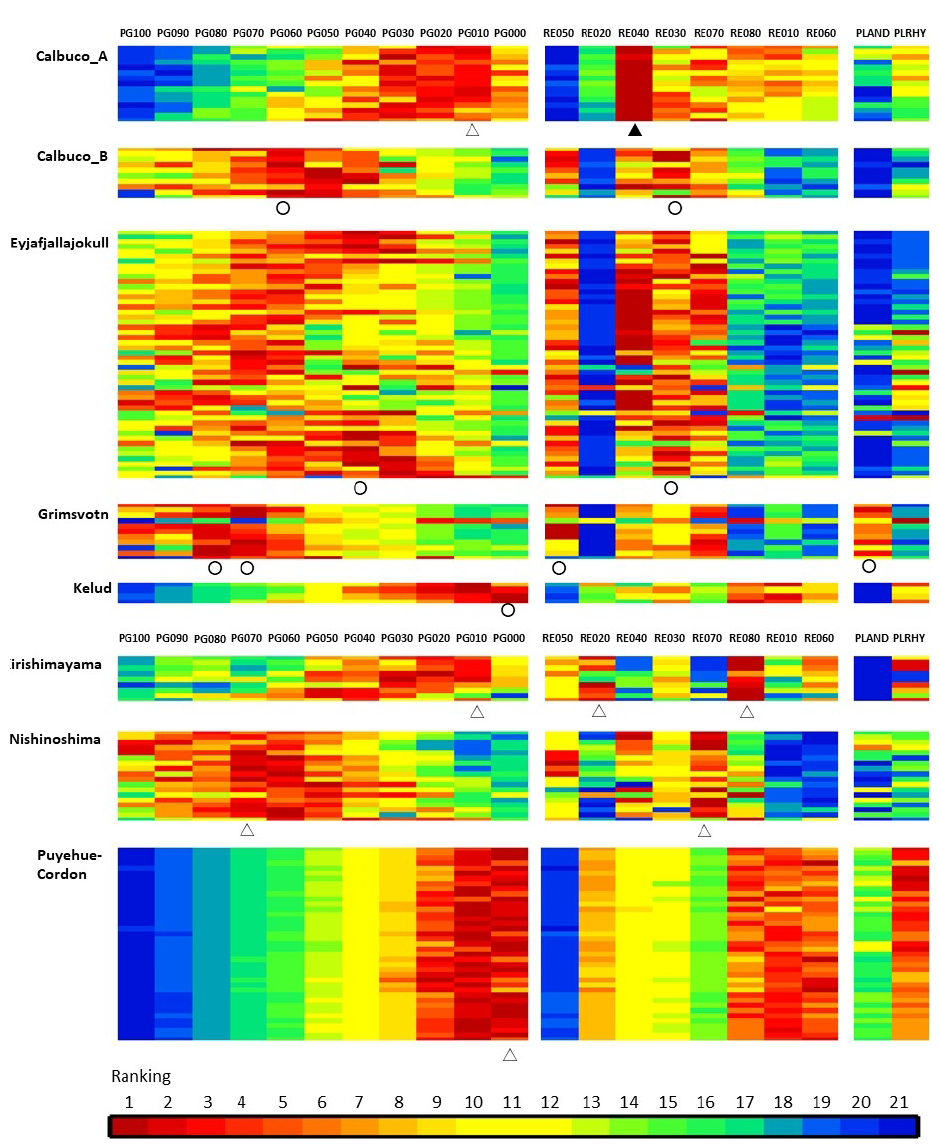
Figure 8. Ranking plots showing the results of BTS simulations for the pixels used for the IASI ash plume measurements in Table 2. The ranking of the 21 RI models is in ascending order of the rms values between the measured and simulated BTS. Results for different pixels are shown on different lines, which are ordered by the date and time of IASI granule measurements from top to bottom. The 11 RI models using the PG2019 dataset are arranged based on NBO/T values (0.0 to 1.0 in steps of 0.1 from right to left), while the eight RI models using the RE2018 dataset and two RI models from PL1973 (PLAND/PLRHY) are arranged based on SiO 2 wt% (Table 1). The RI model for the volcano (Table 2) was determined from the average of rms values for the corresponding measurement pixels. A circle indicates that the BTS simulated using the RI model provides a good fit to the measured BTS, and other RI models are indicated by open triangles ( (cid:77) ). The RI model with a solid triangle ( (cid:78) ) resulted in the smallest average of rms values but was rejected because many estimated r eff values reach the assumed minimum size